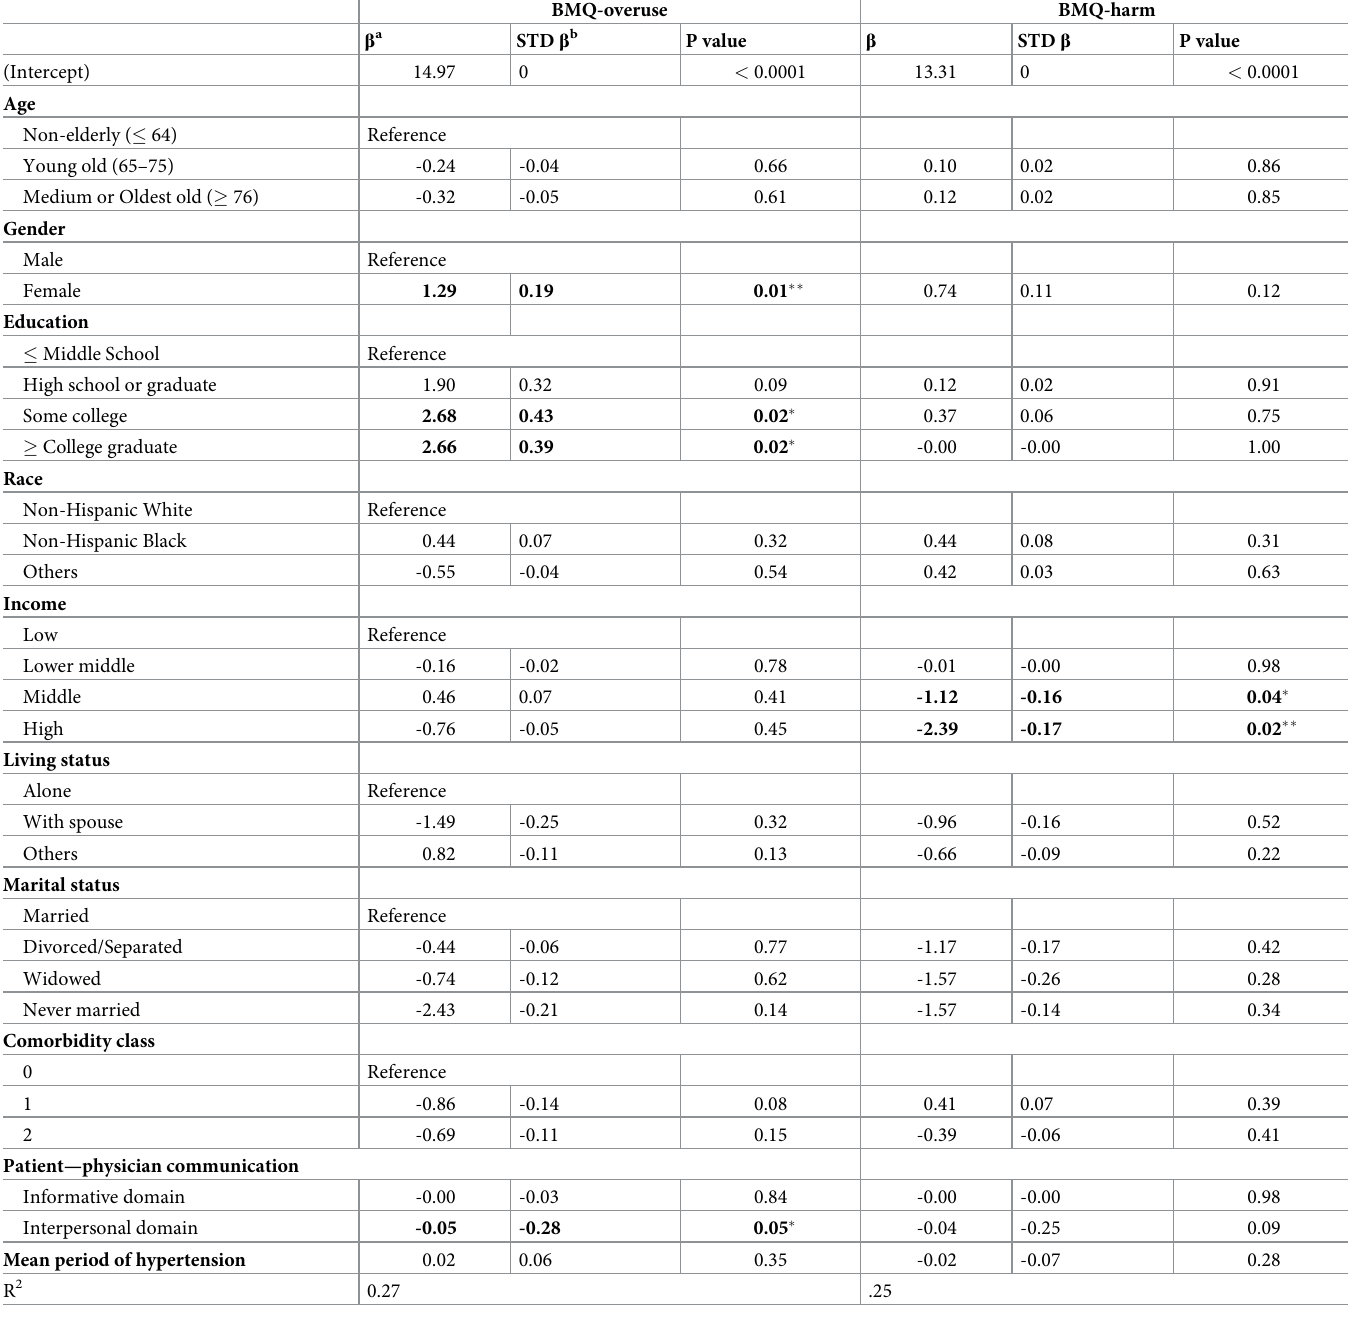
Table 4. Predictability of patient-physician communication on medication